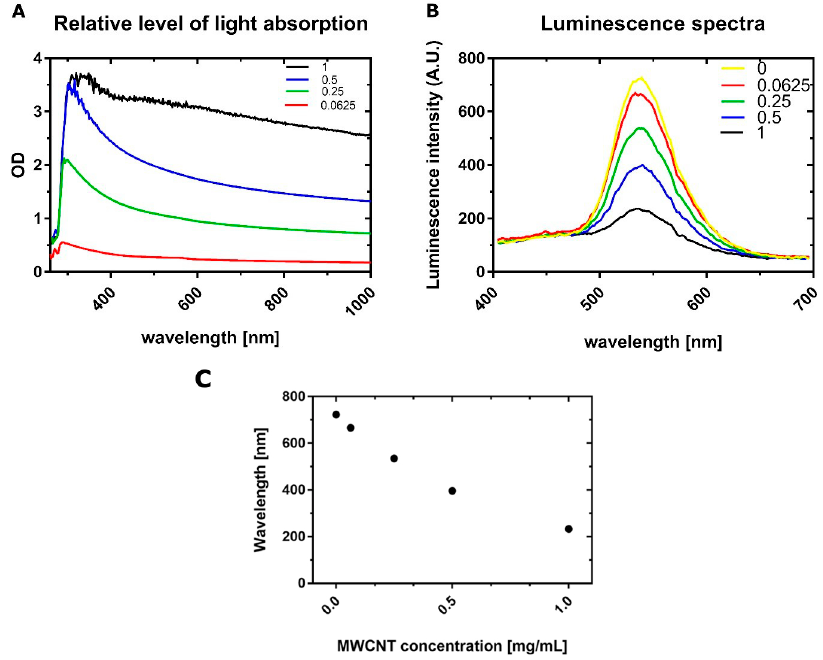
Figure 6. The Absorption spectrum of MWCNT-Ox used for experiments is shown on the ( A ) plot. The curves correspond to the respective concentrations of MWCNT-Ox. The maximum absorption is visible around 300 nm; however, it is observed throughout the whole range. The ( B ) plot shows luminescence spectra generated by the firefly luciferase from the CellTiter Glo assay, with a peak at λ = 532 nm. With an increasing amount of MWNCTs, the signal intensity is diminishing. When comparing both spectra, there is a visible overlap, which may indicate that some of the generated luminescent signals may be absorbed. The ( C ) plot represents a trend of decreasing maximum luminescence intensities with increasing concentrations of MWCNTs.